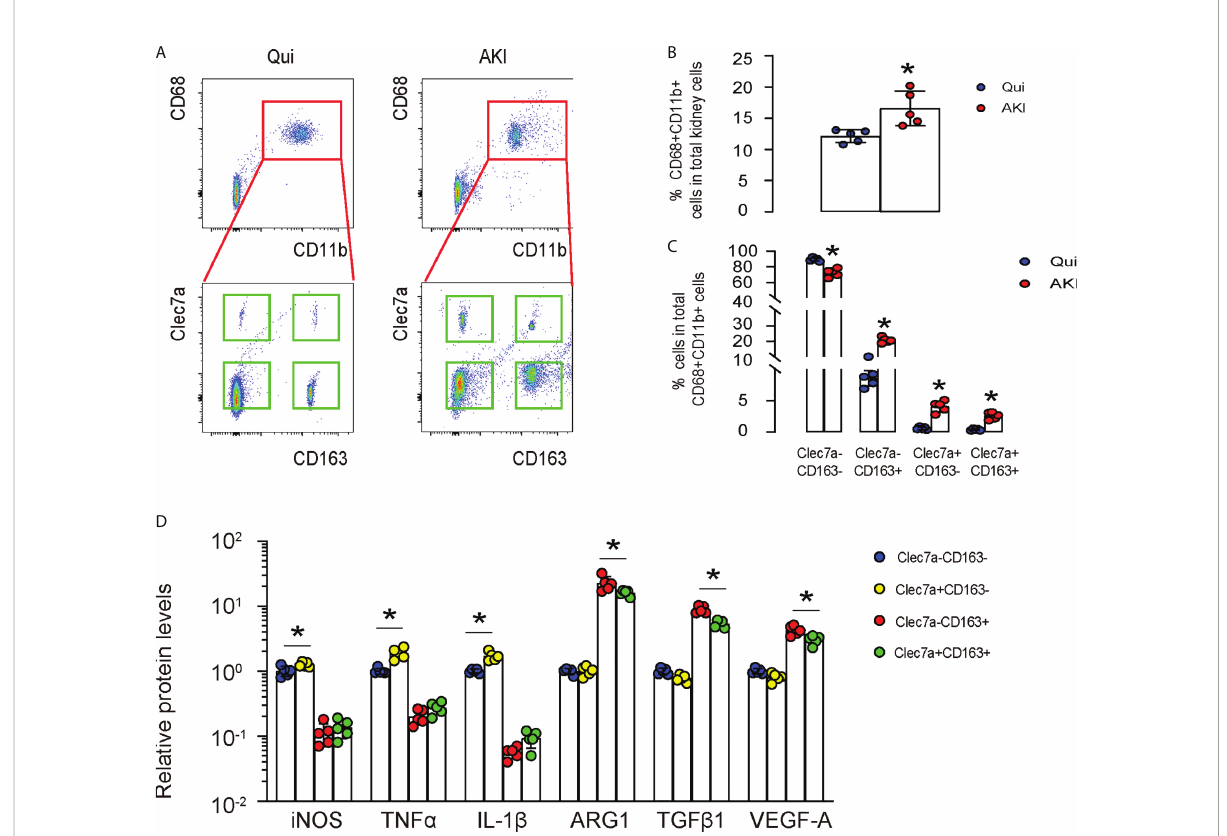
FIGURE 2 Differential expression of Clec7a in renal macrophages at quiescence and during AKI. (A – C) In a mouse renal ischemia/reperfusion injury (IRI) model for AKI, we isolated renal macrophages based on their double positivity for CD68 and CD11b, and then further separated them based on their positivity for CD163 and Clec7a to obtain 4 populations: Clec7a+CD163- M1 macrophages, Clec7a-CD163- M1 macrophages, Clec7a +CD163+ M2 macrophages and Clec7a-CD163+ M2 macrophages, shown by representative fl ow charts (A) , and by quanti fi cation for the percentage of CD68+CD11b+ macrophages (B) and of 4 different subpopulations (C) . (D) ELISA for some genes associated with macrophage polarization and function.